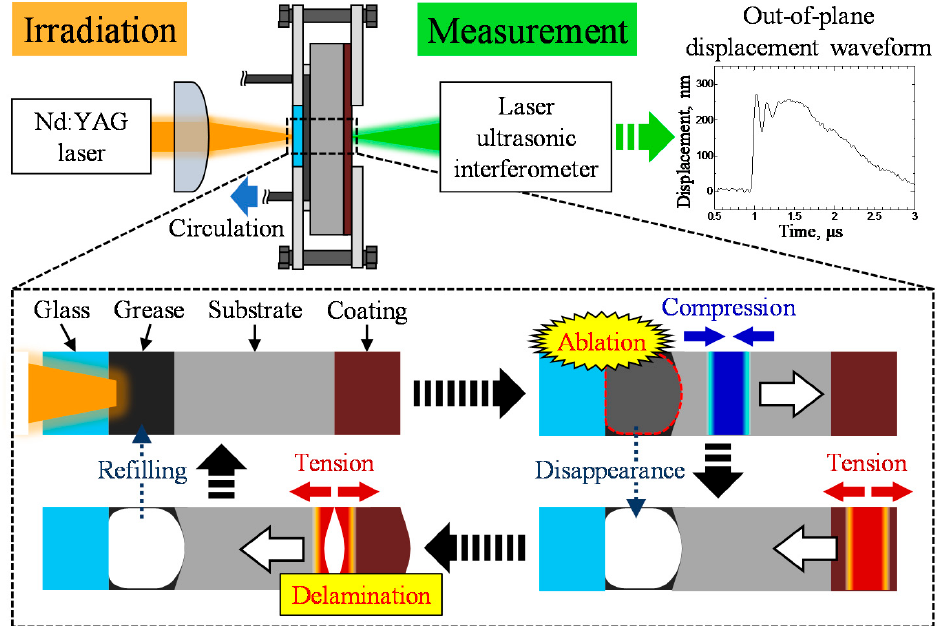
Figure 1. Overview of laser shock-wave adhesion test (LaSAT).